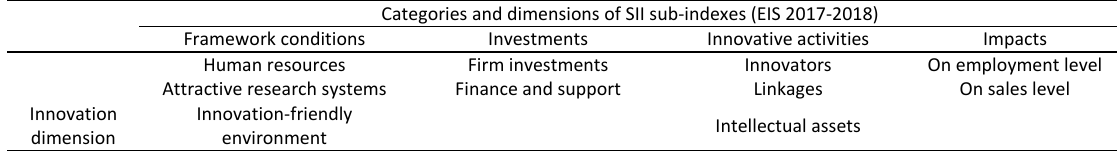
Table 1: Components of summary innovation index Categories and dimensions of SII sub-indexes (EIS 2017-2018)